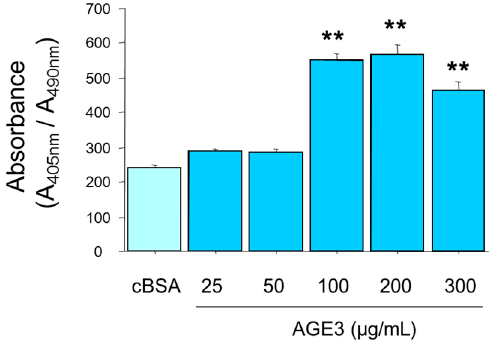
Figure 2. AGE3-BSA treatment induced apoptosis in A7r5 rat vascular smooth muscle cells. The cells were treated with cBSA, or indicated concentrations of AGE3-BSA, and the levels of apoptotic cells were measured using an ELISA-based method, as described in the Method section. Apoptosis was found to be increased by AGE3-BSA after treatment for five days. The results are presented here as averages ± SE of at least three independent experiments. The statistical significance of the results was analyzed by one-way ANOVA followed by LDS post-hoc test. Statistical significance was denoted as follows, ** p < 0.001 vs. cBSA.